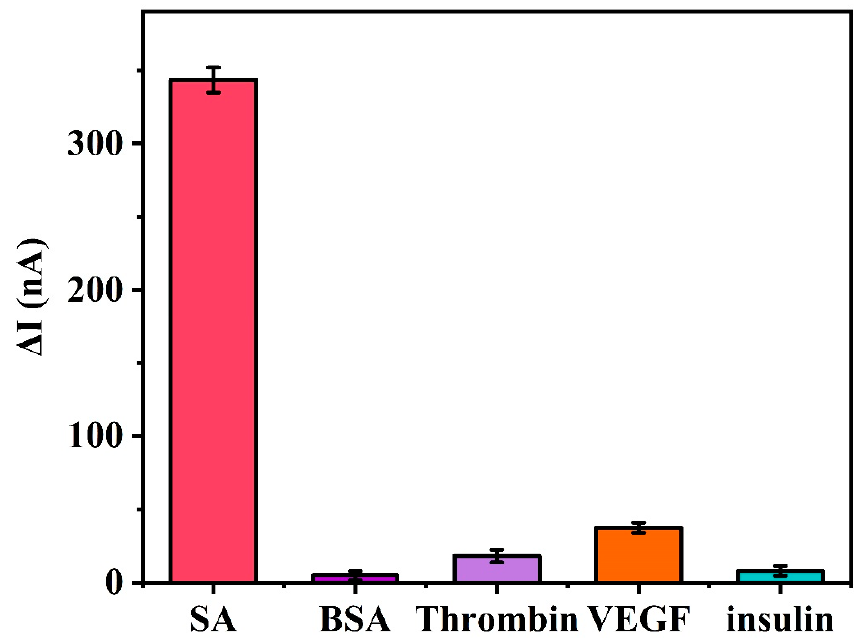
Figure 7. Specificity of the electrochemical DNA sensors based on terminal protection. The concentration of SA was 100 nM and the other non-specific proteins were present at concentrations of 1 μ M. Error bars represent the standard deviation of the measurement (n = 3).